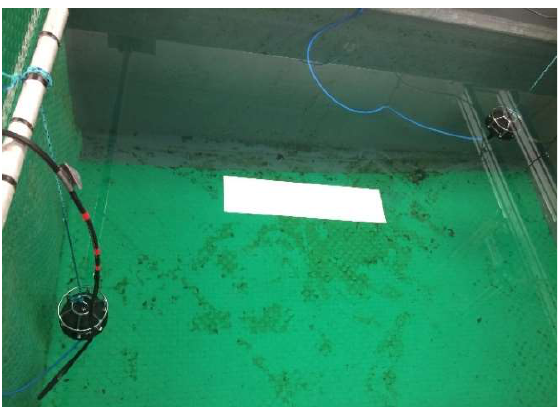
Figure 10. Location of the transducers and hydrophones for the forward and feedback links during the frame-based adaptive modulation tank experiment.